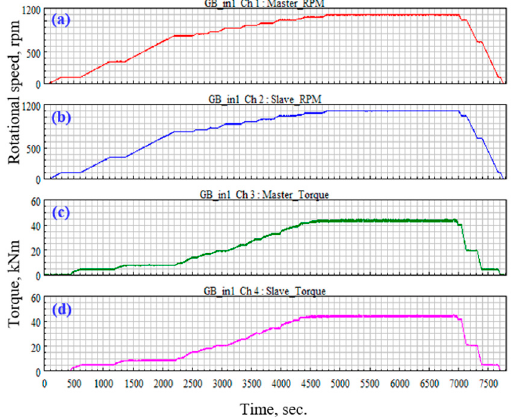
Figure 14. Test result of rotational speed and torque change for the test rig validation.